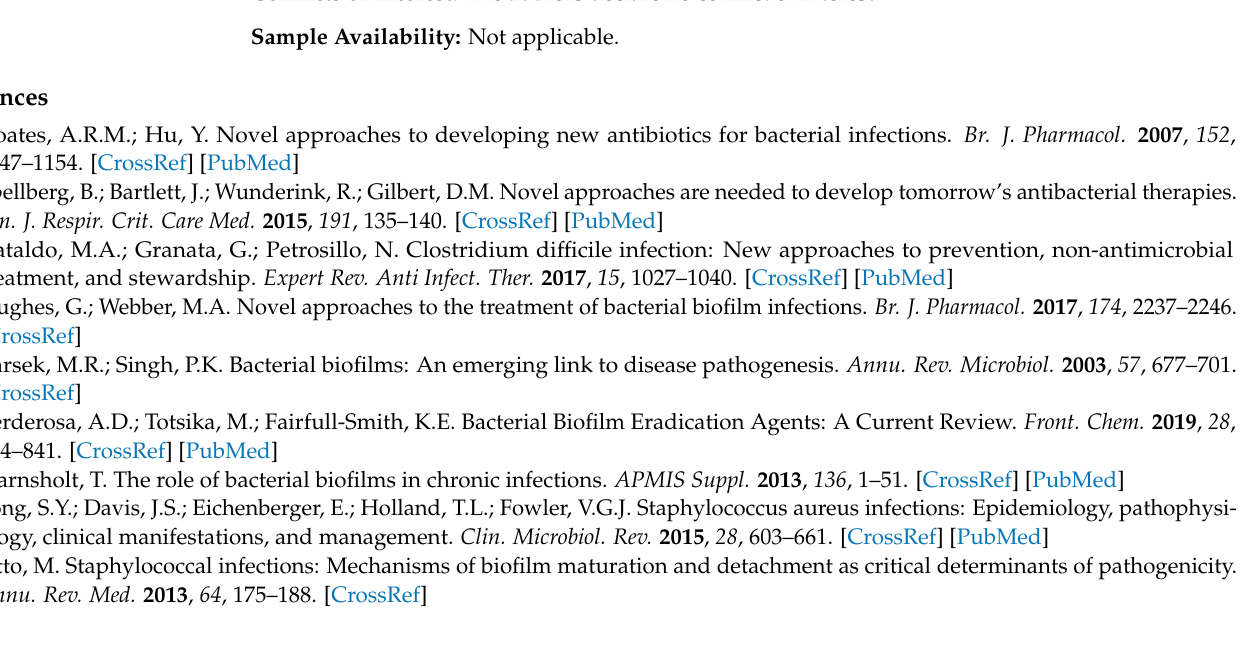
3 ) in CDCl 3 ; Figure S7: MS spectrum of 3 β -phenylacetoxy-5 α -androstan-17-one isonicotinoylhy- drazone (compound 3 ); Figure S8: 13 C NMR spectrum of compound 4 in d 6 -DMSO; Figure S9: 1 H NMR spectrum of 3 α -hydroxy-5 α -pregnan-20-one thiosemicarbazone (compound 5 ) in d 6 -DMSO; Figure S10: 13 C NMR spectrum of 3 α -hydroxy-5 α -pregnan-20-one thiosemicarbazone (compound 5 ) in d 6 -DMSO; Figure S11: 13 C NMR spectrum of compound 6 in d 6 -DMSO; Figure S12: 1 H NMR spectrum of 3 α -hydroxy-5 α -androst-9(11)-en-17-one isonicotinoylhydrazone (compound 7 ) in d 6 - DMSO; Figure S13: 13 C NMR spectrum of 3 α -hydroxy-5 α -androst-9(11)-en-17-one isonicotinoylhy- drazone (compound 7 ) in d 6 -DMSO; Figure S14: 13 C NMR spectrum of androsta-1,4-diene-3,17-dione dithiosemicarbazone (compound 8 ) in d 6 -DMSO; Figure S15: 13 C NMR spectrum of 3 β -acetoxy-5 α - androstan-17-one m -nitrobenzoylhydrazone (compound 9 ) in d 6 -DMSO; Figure S16: 13 C NMR spec- trum of 3 β -acetoxy-5 α -androstan-17-one m -bromobenzoylhydrazone (compound 10 ) in d 6 -DMSO; Figure S17: 1 H NMR spectrum of 3 α -hydroxy-5 α -androstan-17-one m -nitrobenzoylhydrazone (compound 11 ) in d 6 -DMSO; Figure S18: 13 C NMR spectrum of 3 α -hydroxy-5 α -androstan-17-one m -nitrobenzoylhydrazone (compound 11 ) in d 6 -DMSO; Figure S19: IR spectrum of 3 α -hydroxy-5 α - androstan-17-one m -bromobenzoylhydrazone (compound 12 ) in KBr; Figure S20: 1 H NMR spec- trum of 3 α -hydroxy-5 α -androstan-17-one m -bromobenzoylhydrazone (compound 12 ) in d 6 -DMSO; Figure S21: 13 C NMR spectrum of 3 α -hydroxy-5 α -androstan-17-one m -bromobenzoylhydrazone (compound 12 ) in d 6 -DMSO; Figure S22: Fragment of 13 C NMR spectrum 3 α -hydroxy-5 α -androstan- 17-one m -bromobenzoylhydrazone (compound 12 ) in d 6 -DMSO; Figure S23: MS spectrum of 3 α - hydroxy-5 α -androstan-17-one m -bromobenzoylhydrazone (compound 12